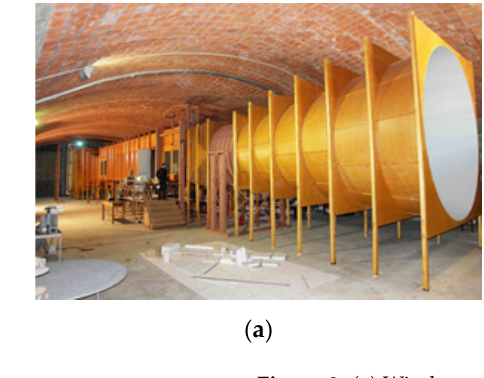
Figure 3. ( a ) Wind tunnel at the School of Engineering of the Universidad de “la República” Uruguay; ( b ) the Standen Method for the establishment of the vertical wind profile according to roughness length and mean wind speed.